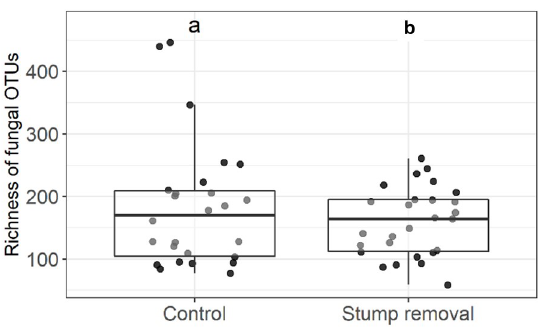
Figure 2. Effect of stump removal on richness of fungal OTUs. Middle lines, boxes, whiskers, and circles represent medians, quartiles, 90% quantiles, and all sampled trees, respectively. Different